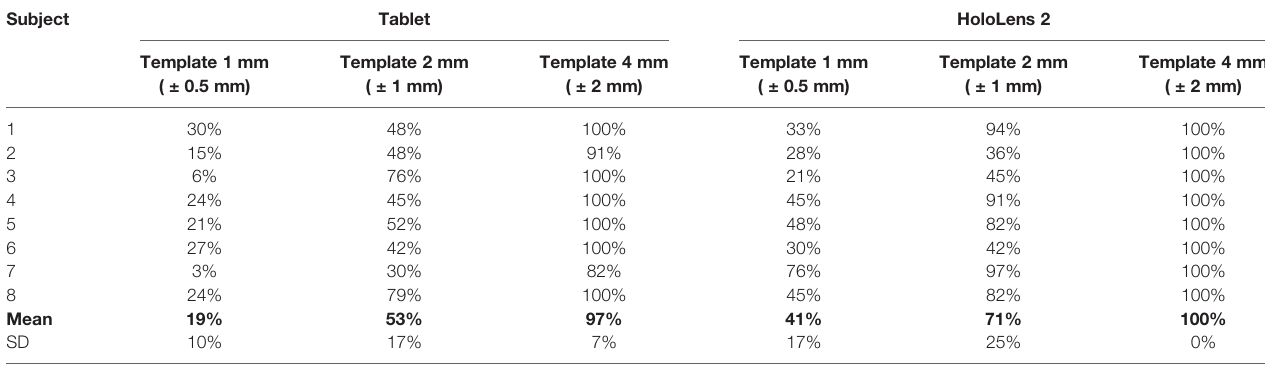
TABLE 1 | Resulting mean percentage success rate in performing the AR-guided task using both tablet and HoloLens 2, for different accuracy levels ( “ 1 mm ” , “ 2 mm ” , “ 4 mm ” templates). Subject Tablet HoloLens